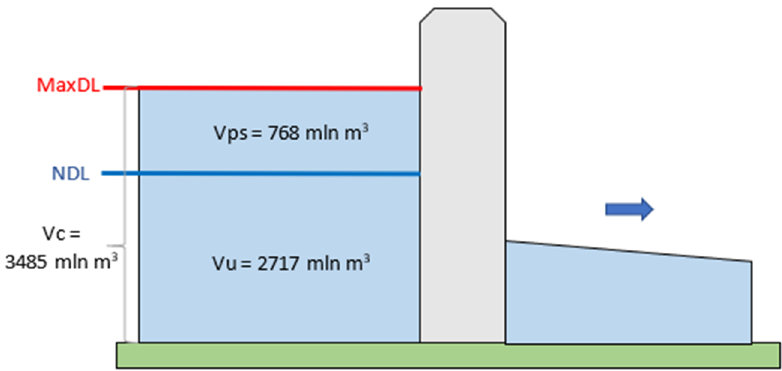
Figure 2. The current capacity of the analyzed 47 key reservoirs in Poland. Explanations: NDL (normal damming water level)—the highest level of the water table in normal conditions of use; MaxDL (maximum damming water level)—the highest level of the dammed water table, taking into account the permanent flood reserve; V u (usable volume of the reservoir)—the capacity of the reservoir intended to be used for specific purposes of this reservoir, between the minimum damming water level and the normal damming level; V ps (permanent flood capacity of the reservoir)—reservoir capacity intended to be used when the flood wave is passing, between the normal damming level and the maximum damming level; V c (total capacity of the reservoir)—reservoir capacity taking into account the total value of V u and V ps . Table 1. Calculated changes in capacity at MaxDL in reservoirs of key importance for water management in Poland.